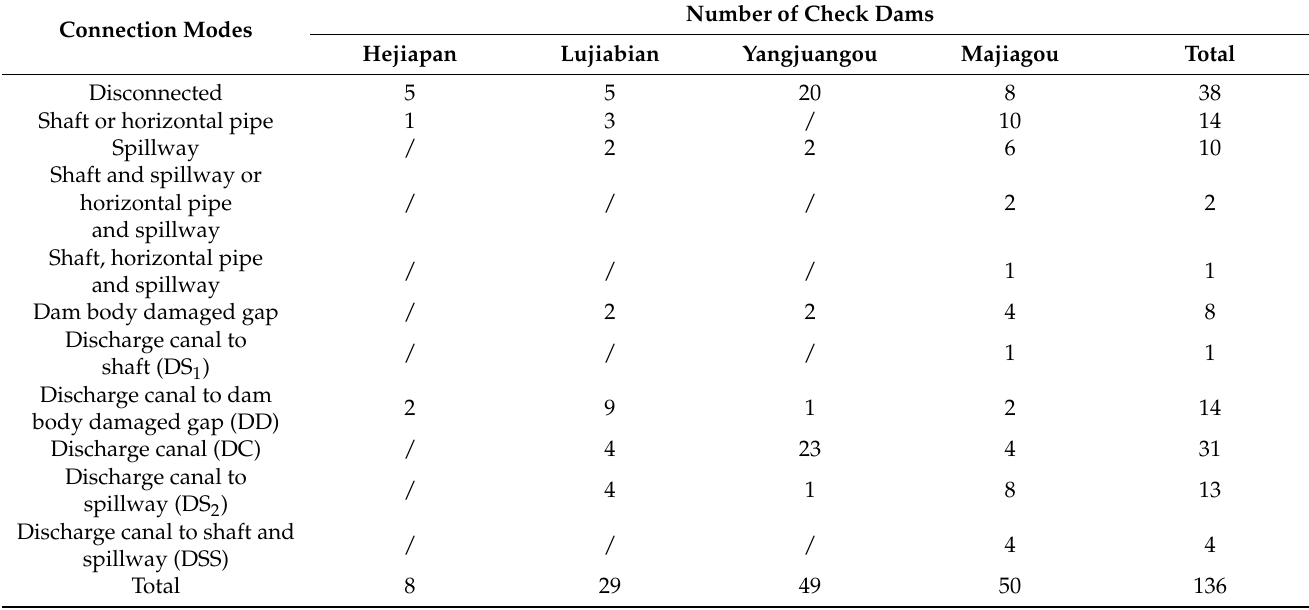
Figure 2. Different connection modes of check dams with a downstream channel. Table 1. Number of check dams with different connection modes in the four typical